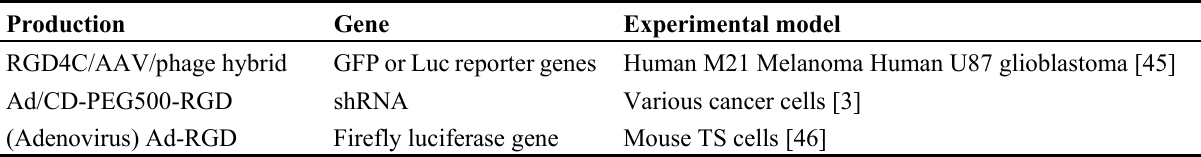
Table 2. RGD-modified viruses for gene